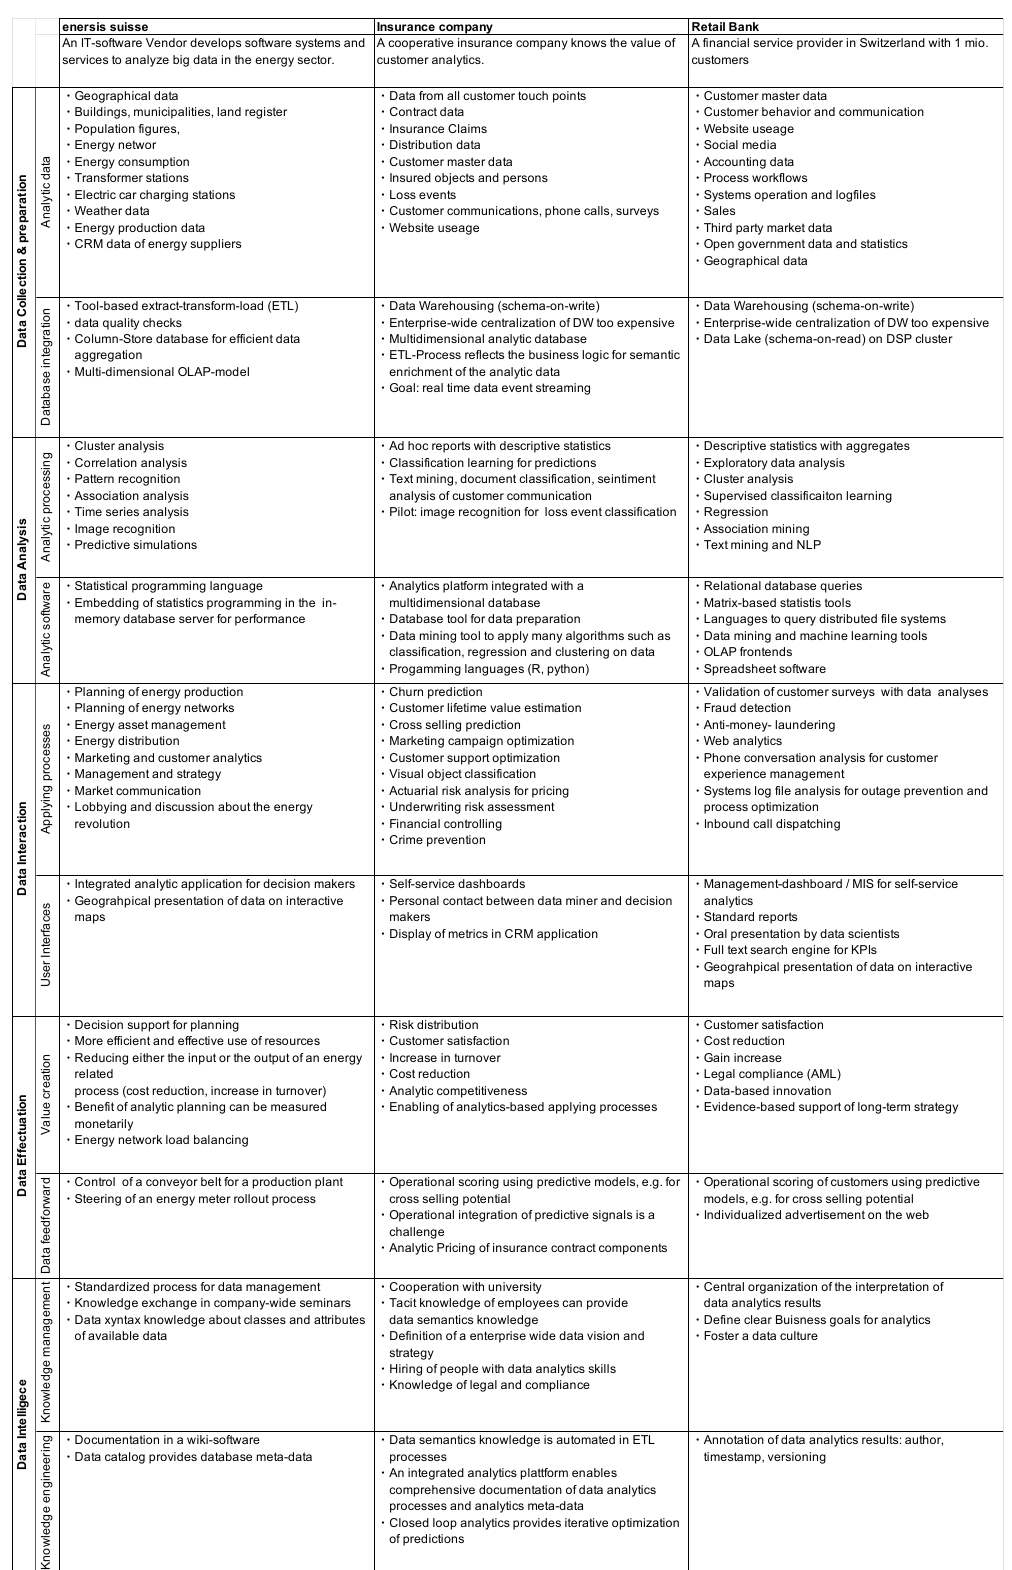
Figure 5. Summary of the case studies with mapping to the reference model.